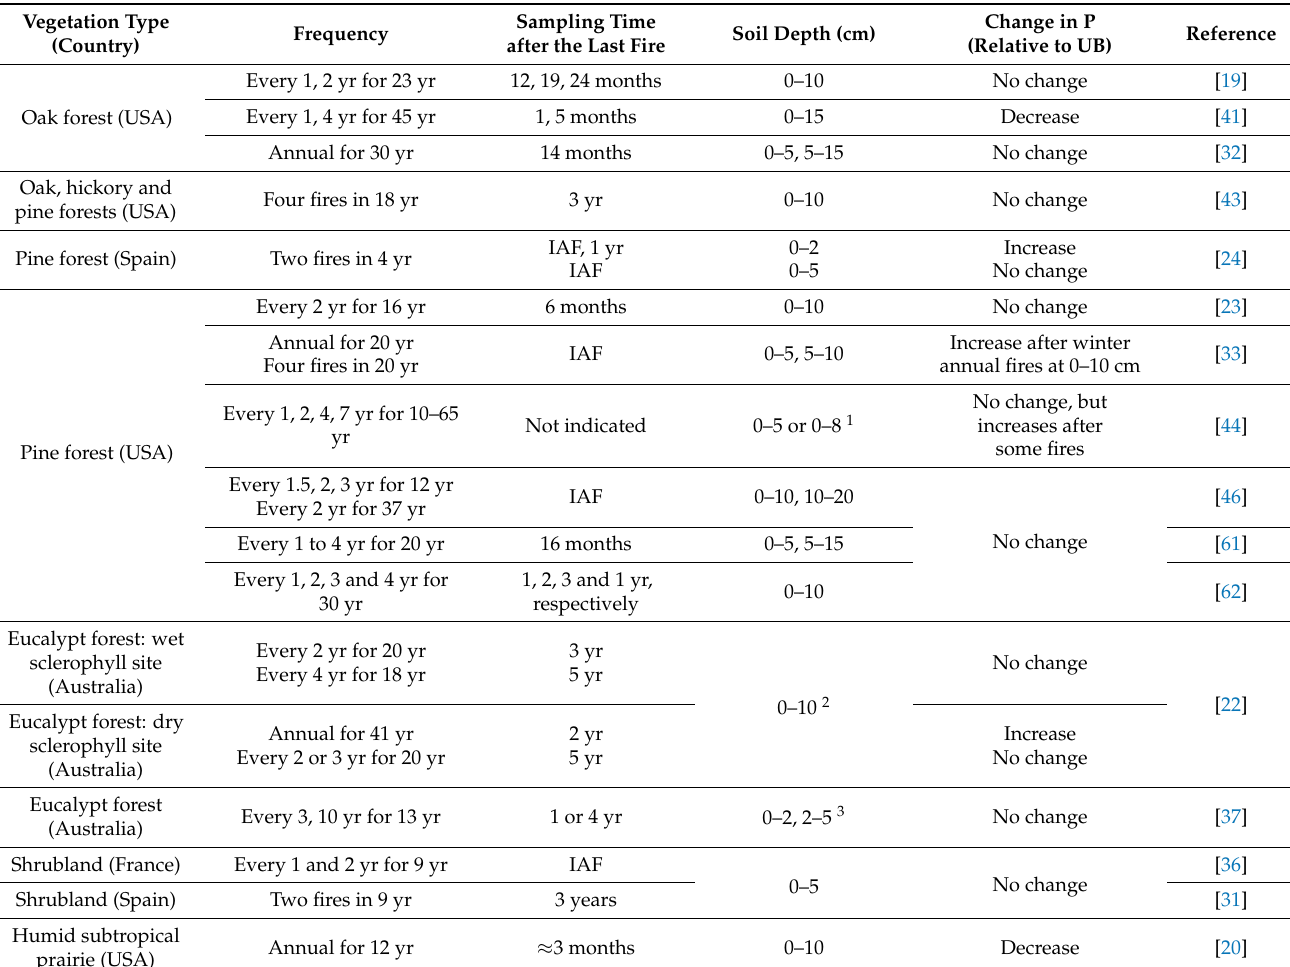
Table 5. Studies including the effects of repeated prescribed fires on soil extractable or exchangeable phosphorus (P). UB: unburned soil; yr: year; IAF: immediately after